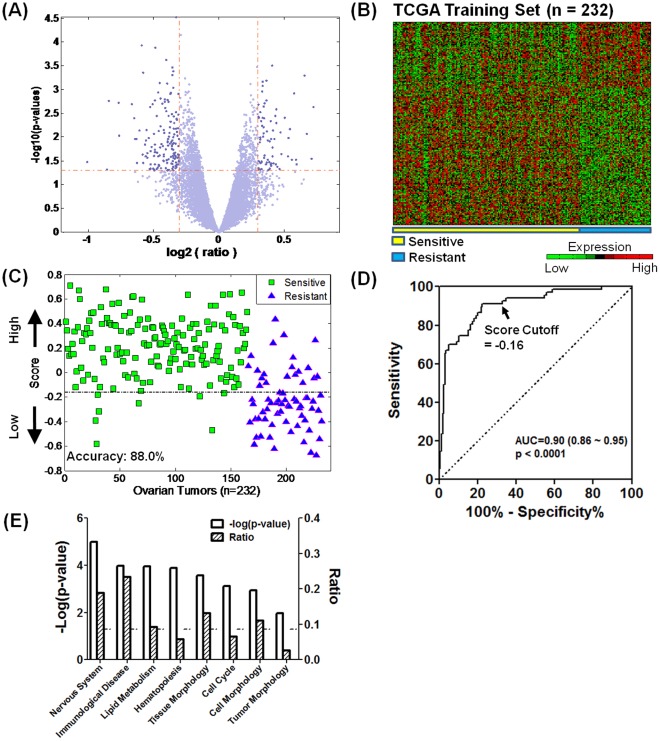
Gene signature associated with chemotherapy response in serous OvCa.(A) Identification of gene signature differentially expressed in chemoresistant and chemosensitive patients. (B) The selective genes (n = 227) distinguish the chemoresistant patients from the chemosensitive patients. (C) A predictive model on the basis of the gene signature reveals an accuracy of approximately 87.9% in correctly classifying chemoresistant and chemosensitive tumors (n = 232; green square = chemosensitive, blue triangle = chemoresistant). (D) An receiver operating characteristic (ROC) curve illustrates the predictive performance, with a sensitivity of approximately 95.2% and specificity of approximately 70% at the predictive score cutoff of approximately −0.16 that serves as a threshold for patient stratification in the TCGA data set. AUC: area under curve. (E) Pathway analysis shows that the gene signature is enriched in the morphologic function at cellular, tissue, and tumor levels. The dotted line denotes the cutoff for significance (P = 0.05). The shaded bars show the ratio of genes enriched in each function to the 227 genes.